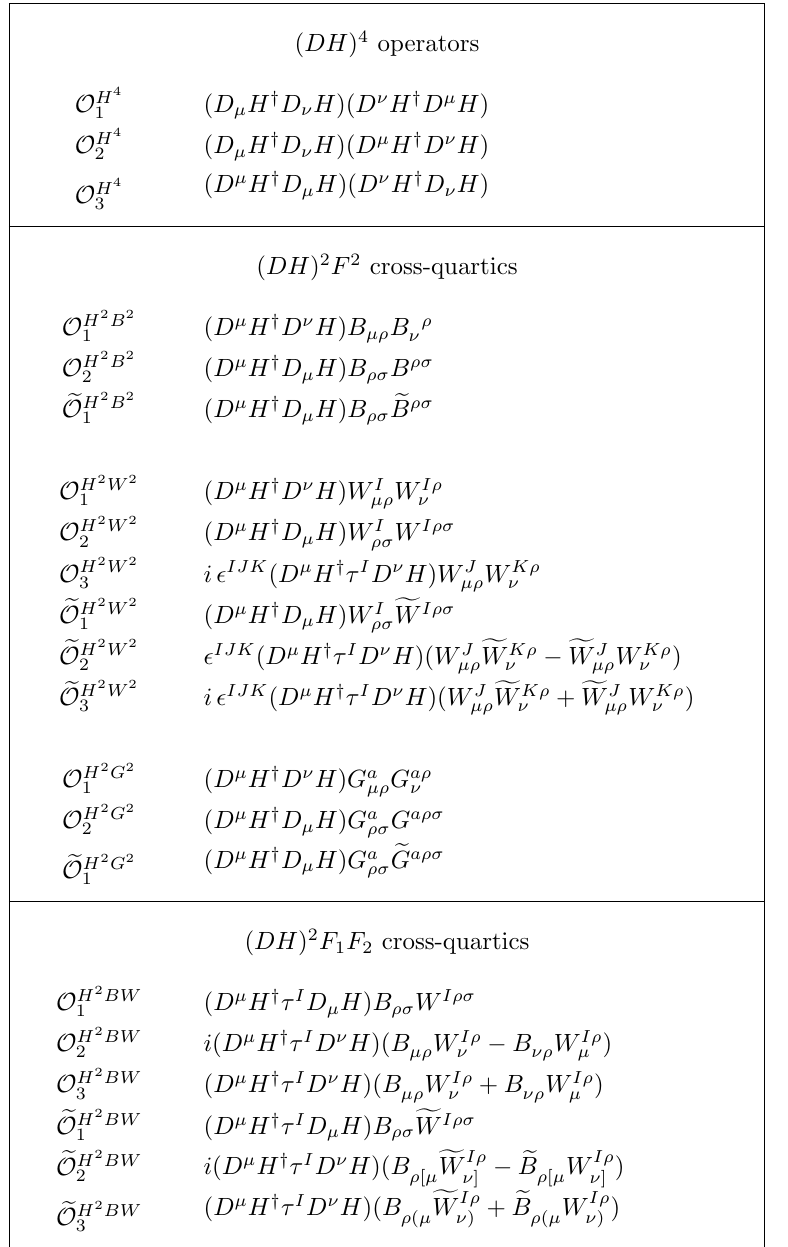
Table 2 . Basis of independent dimension-eight operators in the SMEFT that are quartic in bosons and contain four derivatives and/or (cid:12)eld strengths and at least one Higgs. CP-violating operators are denoted with a tilde. Factors of i ensure that each operator is self-hermitian and thus has real Wilson coe(cid:14)cient.